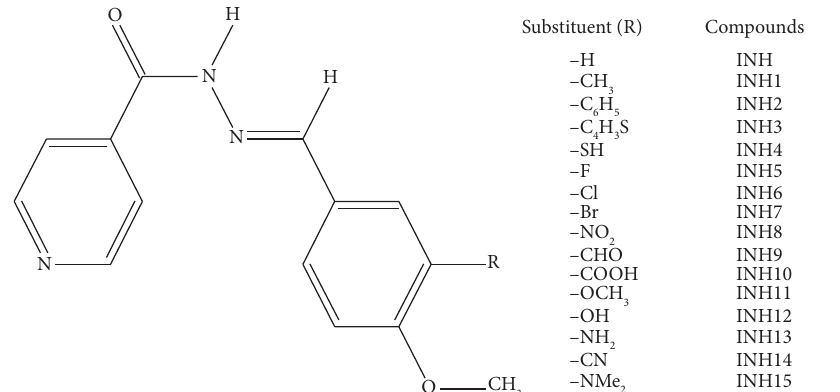
Figure 1: Structural representation of N-(4-methoxybenzylidene) isonicotinohydrazone (INH) and its studied